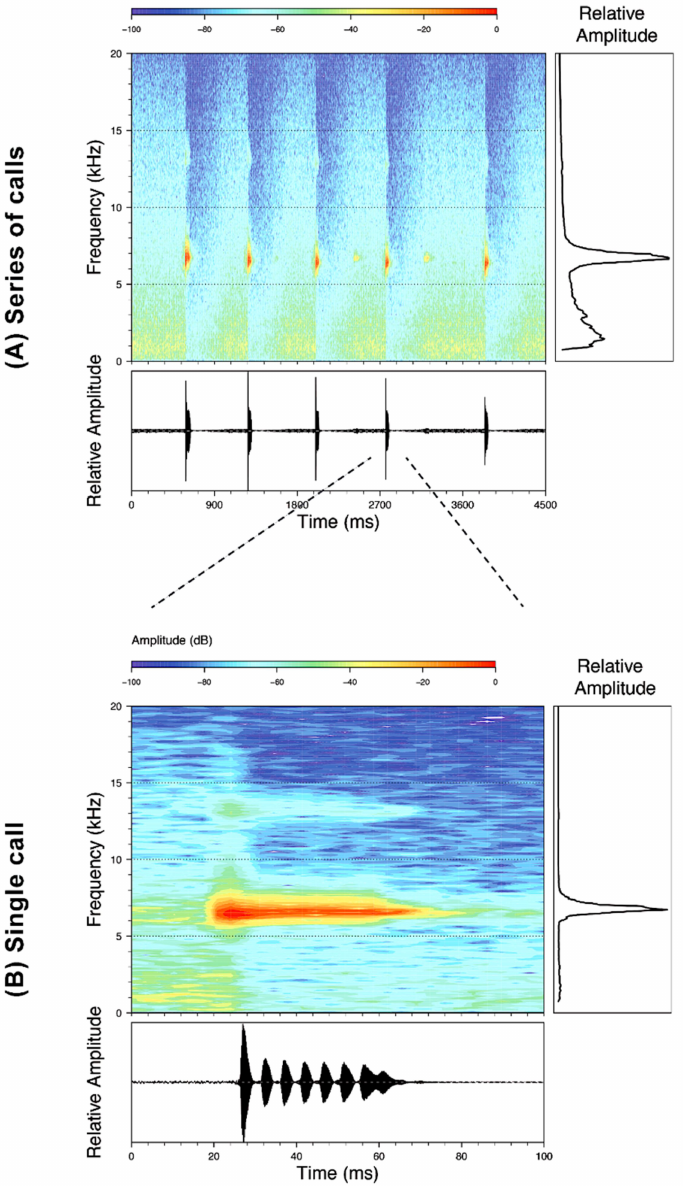
Figure 86. Calls of Espadarana audax , MZUTI 1492, recorded at R í o Holl í n, 1038 m, Napo province, Ecuador. ( A ) Call series. ( B ) Single call. Tadpole: Not